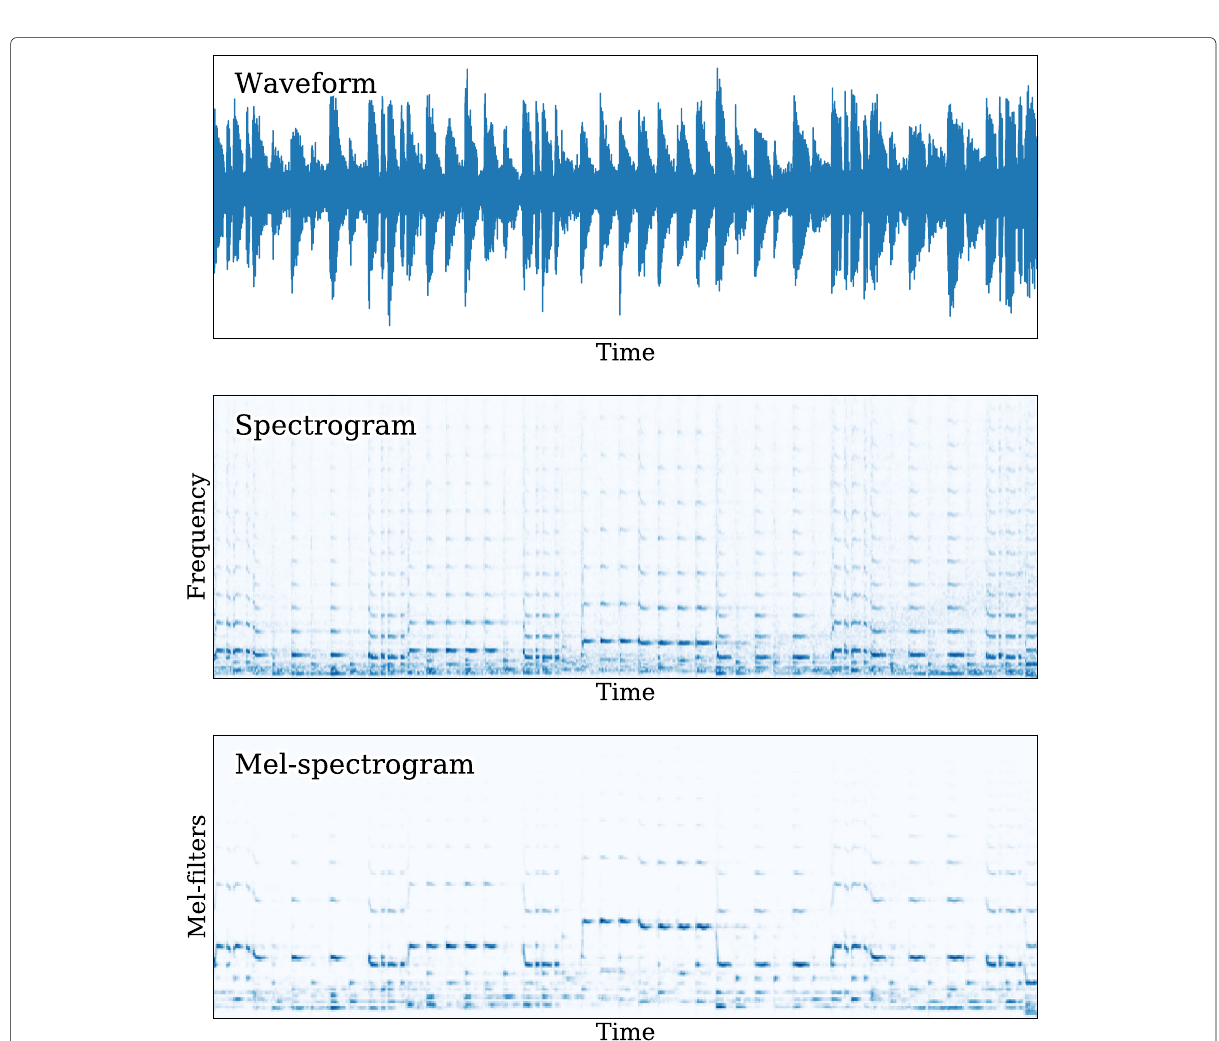
Fig. 2 Waveform, spectrogram, and mel-spectrogram of a 10-s music segment obtained from Google AudioSet. The mel-spectrogram, based on the auditory-based mel-frequency scale, provides better resolution for lower frequencies than the spectrogram